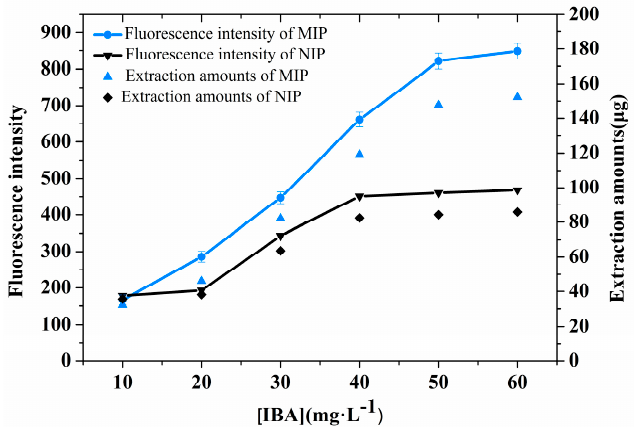
Figure 3. Fluorescence intensities of MIP- and NIP-coated quartz chips in different solutions (5 mg·L − 1 IBA solution, λ ex/em = 294/370